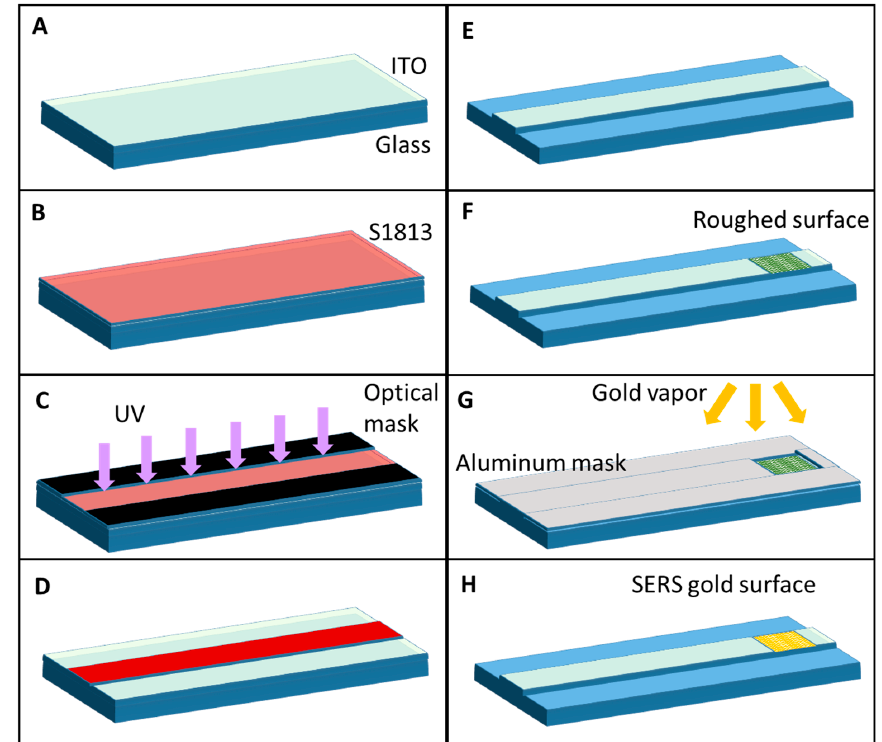
Figure 2. Schematic representation of the fabrication process: ( A ) glass + ITO substrates are clean; ( B ) the positive photoresist S1813 is spun on the substrate; ( C ) the sample is exposed by UV light under an optical mask; ( D ) the exposed resist is developed; ( E ) the ITO is wet-etched to create the OWG; ( F ) the ITO is roughened on one side of the OWG; ( G ) the sample is exposed to gold physical vapor deposition under an aluminum mask to create the SERS surface on top of the ITO roughened surface; ( H ) final device.